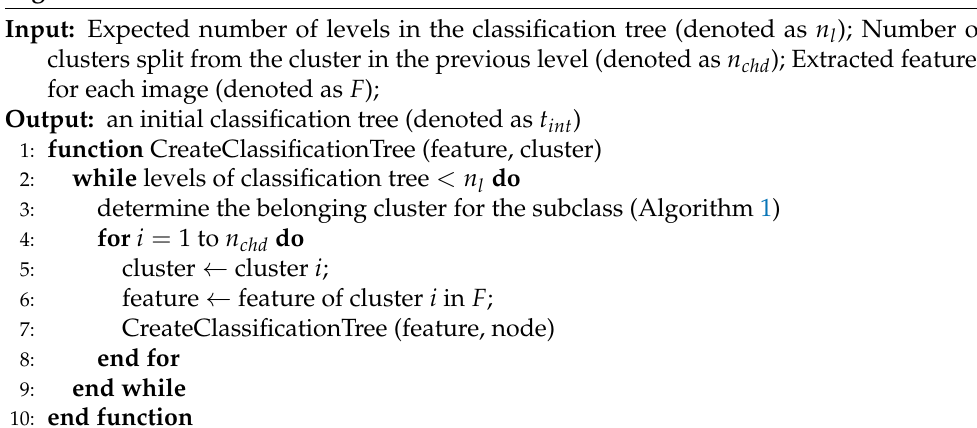
Algorithm 2 Construction of the initial classification